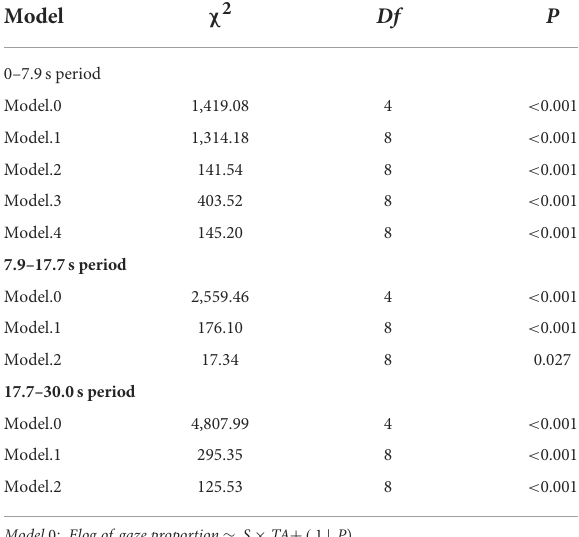
TABLE 2 Gaze proportion GCA model comparisons. TABLE 3 Parameter estimation of gaze proportion